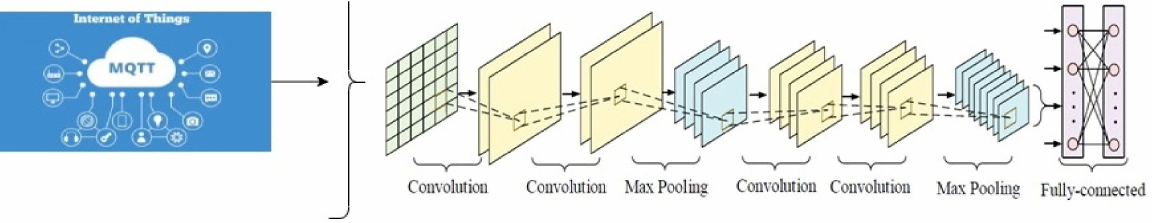
Figure 6. Structure of convolutional neural